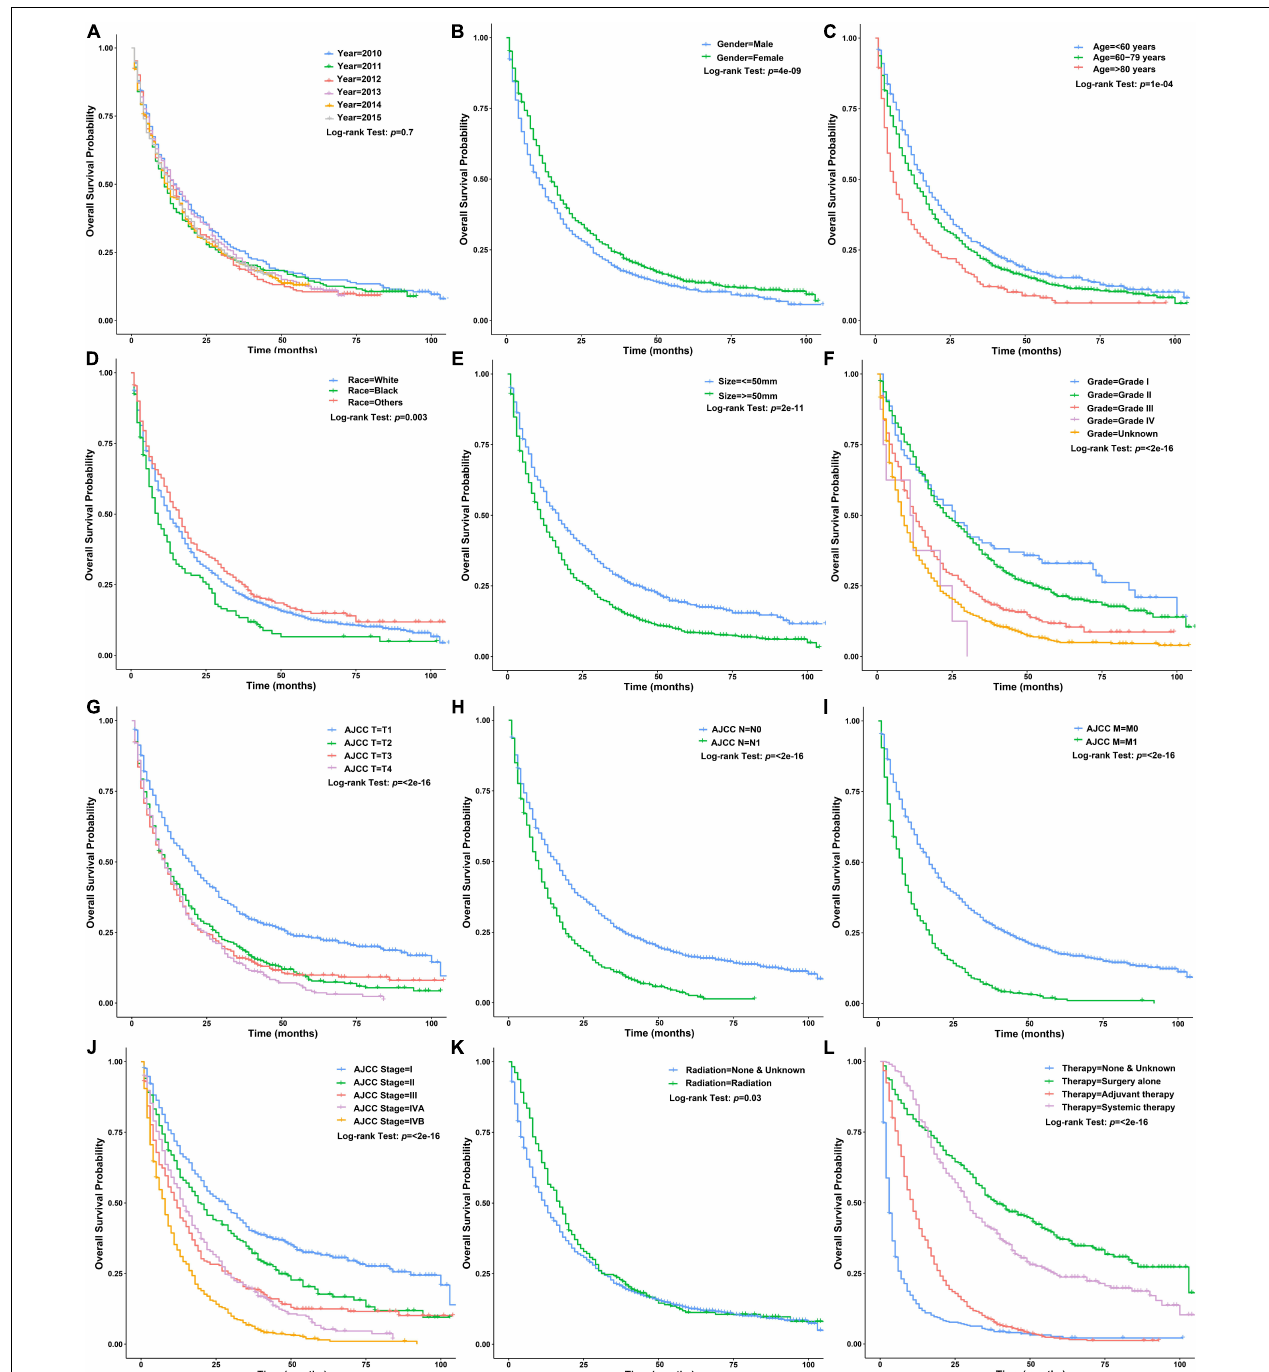
FIGURE 5 | Survival curves of patients with ICCA in different clinicopathological groups in the training dataset. (A) Survival curves of patients with ICCA between different year of diagnosis groups. (B) Survival curves of patients with ICCA between different gender groups. (C) Survival curves of patients with ICCA between different age of diagnosis groups. (D) Survival curves of patients with ICCA between different race groups. (E) Survival curves of patients with ICCA between different tumor size groups. (F) Survival curves of patients with ICCA between different grade groups. (G) Survival curves of patients with ICCA between different AJCC-T groups. (H) Survival curves of patients with ICCA between different AJCC-N groups. (I) Survival curves of patients with ICCA between different AJCC-M groups. (J) Survival curves of patients with ICCA between different AJCC-stage groups. (K) Survival curves of patients with ICCA between different radiotherapy groups. (L) Survival curves of patients with ICCA between different therapy